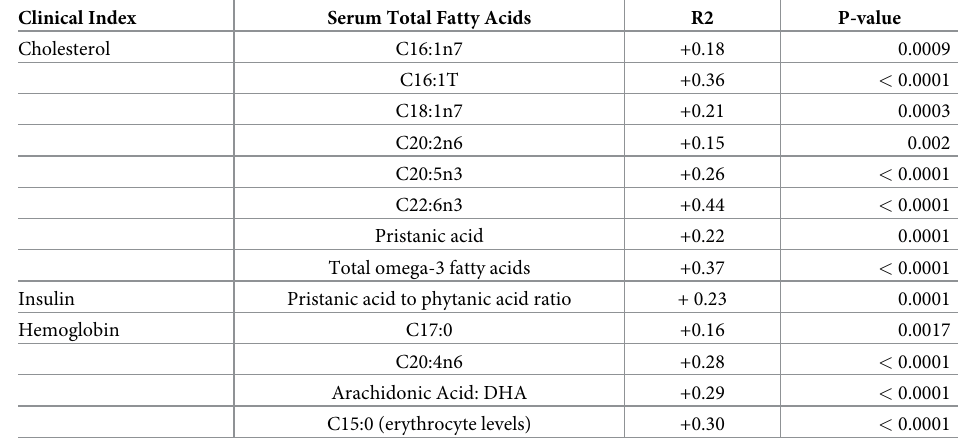
Table 8. Independent and linear dietary and serum fatty acid predictors of targeted clinical indices in bottlenose